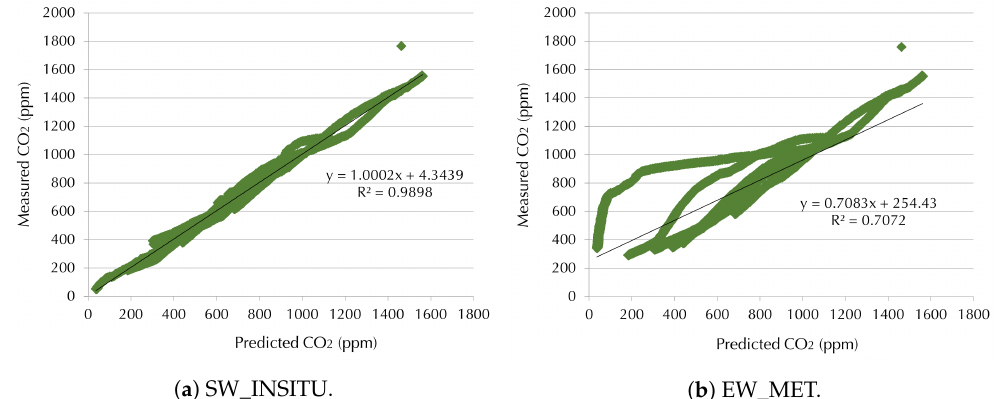
Figure 9. Correlation between predicted and measured CO 2 concentration by DFR models with SW_INSITU ( a ) and EW_MET ( b ) in P_1_T.